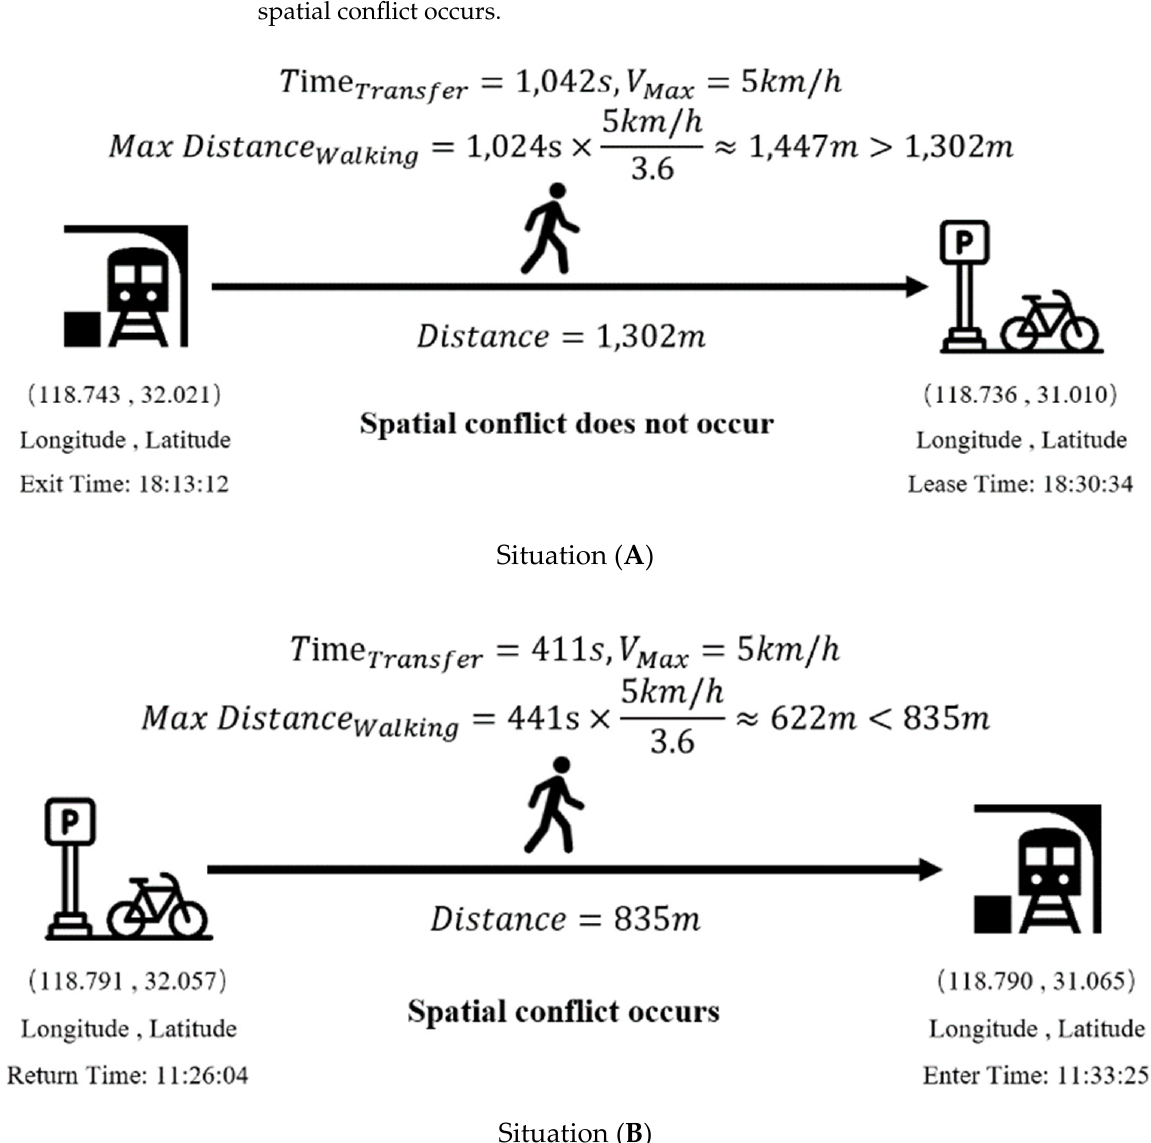
Figure 5. Process of considering spatial conflict.